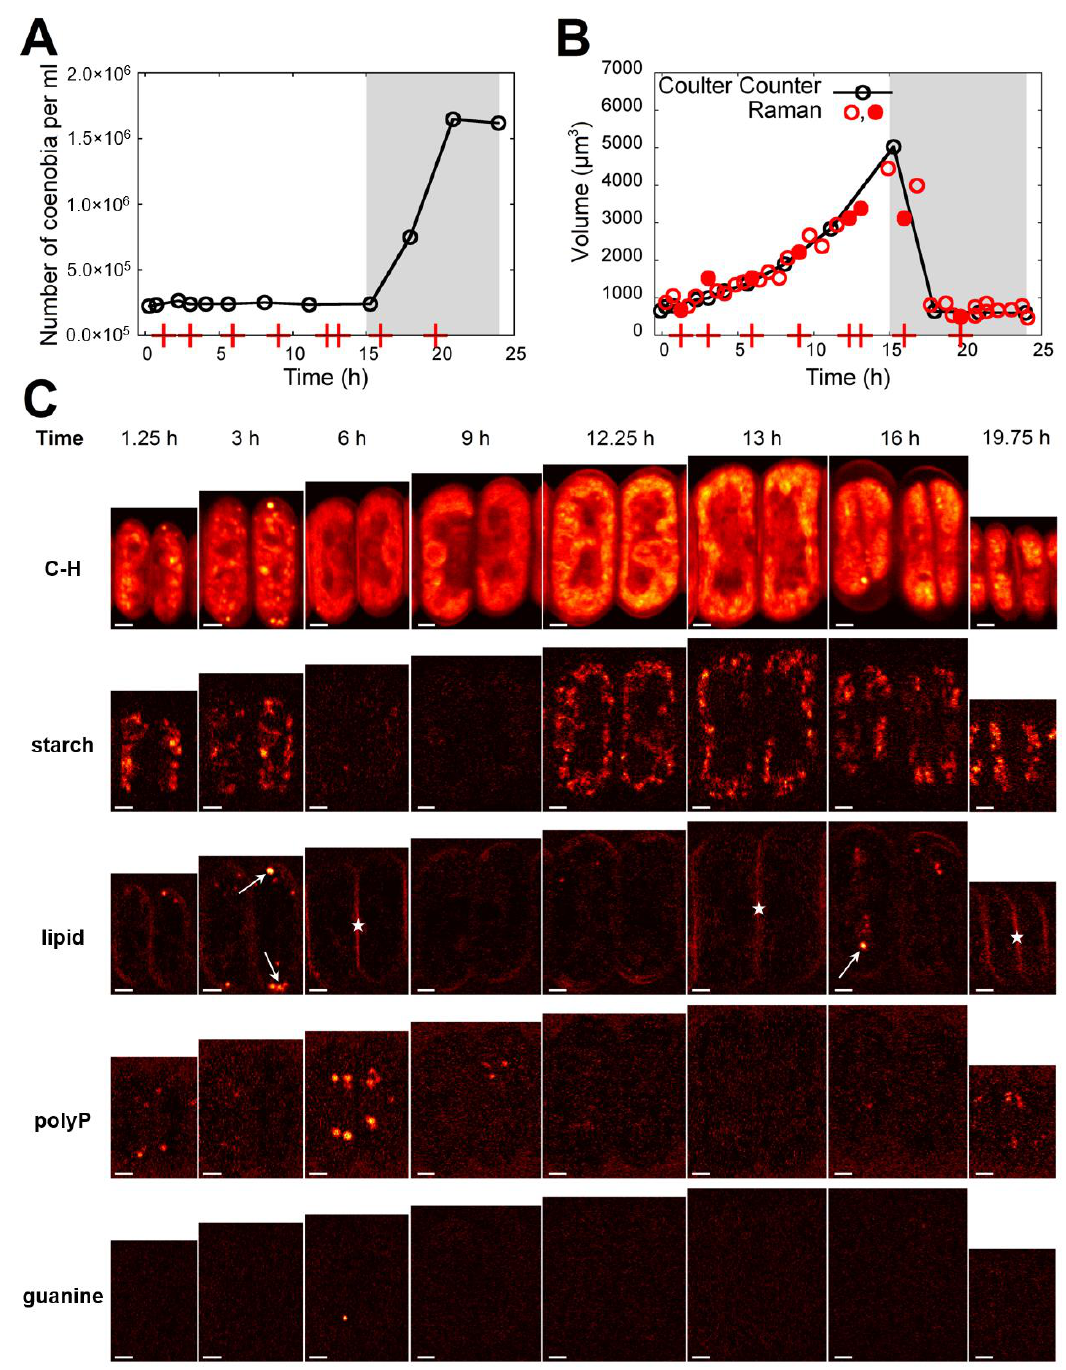
Figure 4. Time course of the number of coenobia in the cell culture of D. quadricauda as determined by Coulter counter ( A ). Time course of volumes of the coenobia determined by Coulter counter (black, median volume) and Raman microscopy (red) ( B ). For the time-point T = 18:05 h coinciding with the cell division of a majority of the cells, the Coulter counter volume of daughter cells is shown. The cells that are shown in panel ( C ) are indicated by filled circles. Raman maps showing the distribution of carbon–hydrogen (C-H) groups, starch, lipids, and polyP in the two innermost cells of eight-celled coenobia during the cell cycle ( C ). Time from start of the cycle is indicated in the top row. For a given biomolecule, the color scale is the same for all Raman maps. The white bars correspond to 2 µ m. The red crosses on the time axis in panels A, B indicate times at which the cells shown in panel C were taken from the culture. The grey area in panels A, B indicates the dark period of the cycle. In panel C, lipids, the arrows depict lipid bodies, the asterisks depict membrane lipids. Spectra of both structures contain the same spectral proxy, Raman band located at ca 2854 cm − 1